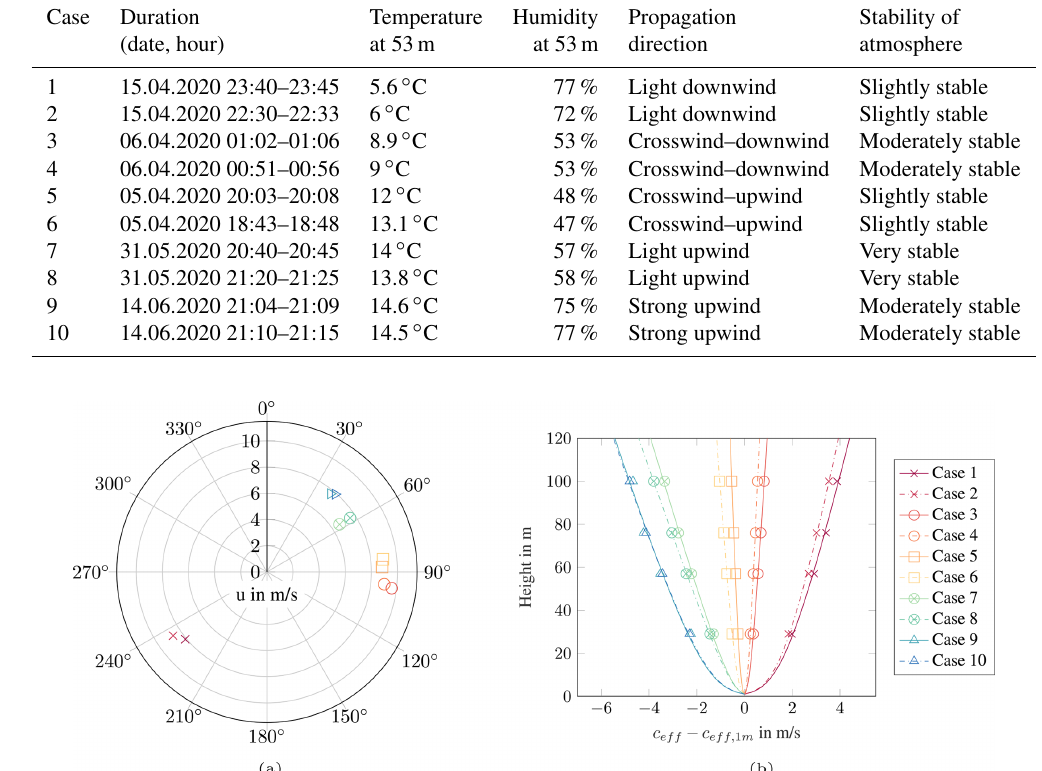
Table 3. Overview of validation cases.